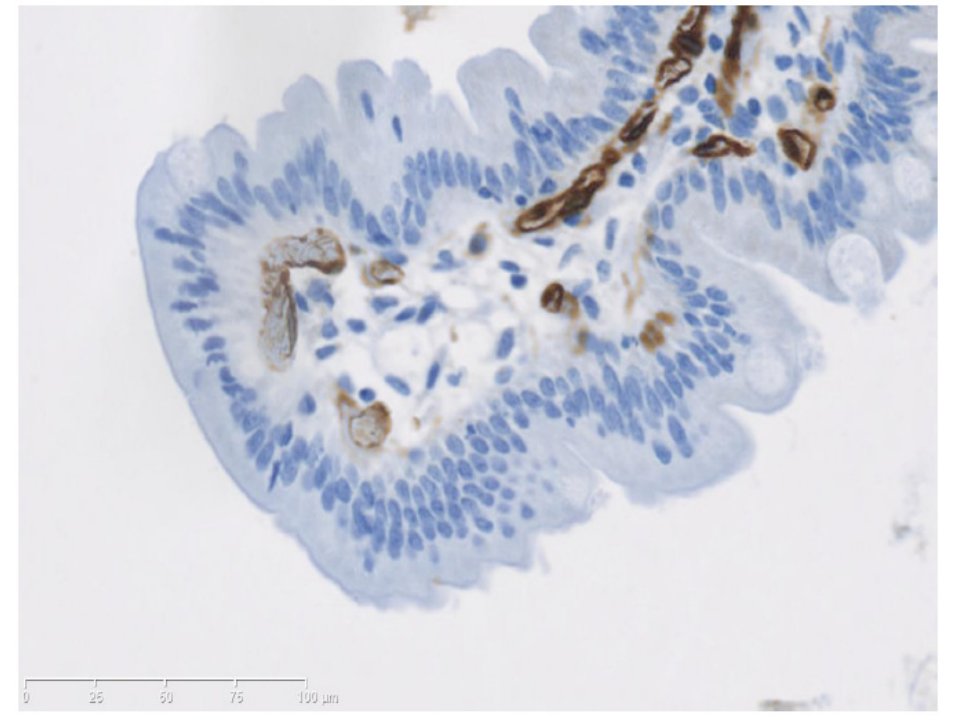
Figure 2. Ulex europaeus agglutinin (UEA) staining. ( a ) Patient C4 (non-CD), score 0; ( b ) Patient A1 (CD + T1D, untreated), score 3; ( c ) Patient A1 (CD + T1D, on GFD), score 2; ( d ) Patient B5 (CD), score 3. Thin arrows mark staining of cytoplasm of epithelial cells. Thick arrows mark staining of glycocalyx. Arrowheads mark staining in goblet